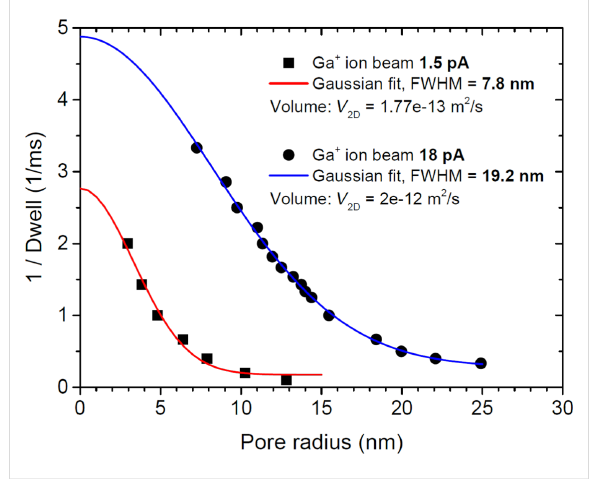
Figure 2: Gaussian fits to the 1/dwell vs pore radius curves. FWHM and volume under the Gaussian lines are extracted for both Ga ions beam currents: 1.5 and 18